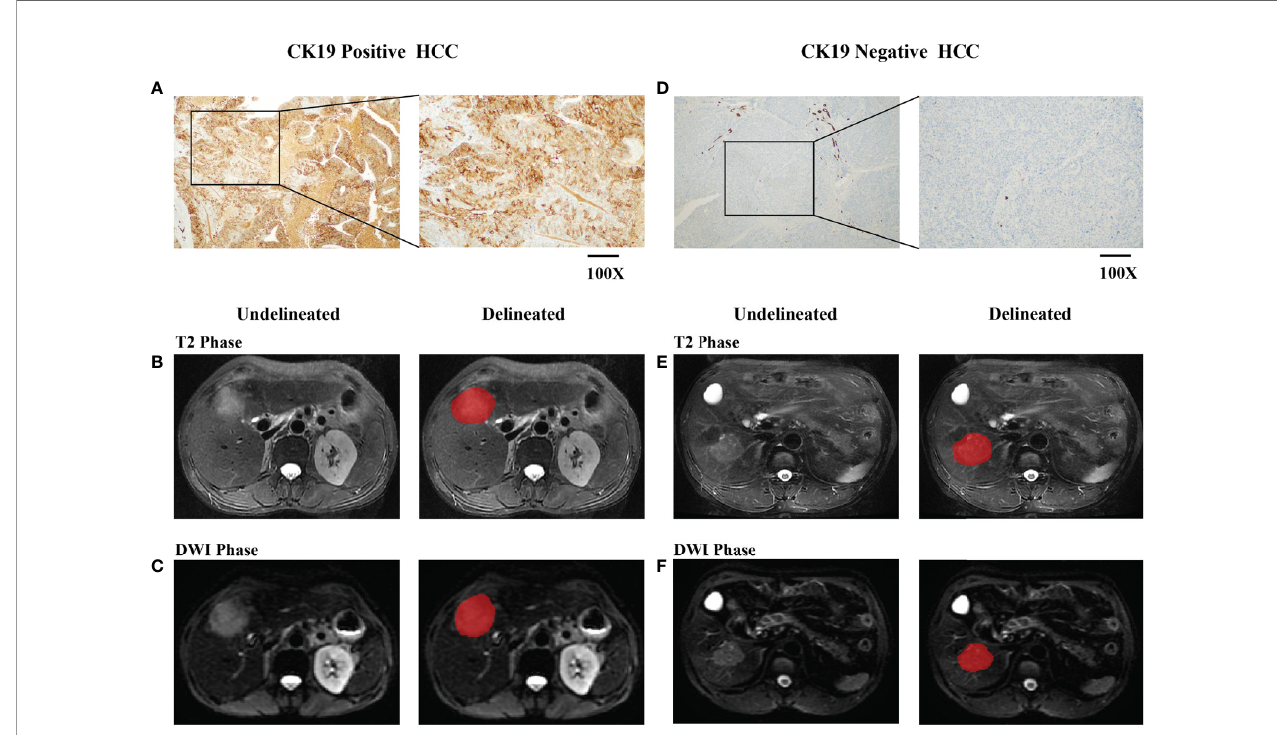
FIGURE 2 | Delineation of the region of interest (ROI). Immunohistochemistry (IHC) staining-based grouping of cytokeratin (CK)19 expression [ (A) , CK19 positive; (D) , CK19 negative]. Undelineated and delineated image of contrast-enhanced T2-weighted imaging [ (B) , CK19 positive; (E) , CK19 negative]. Undelineated and delineated image of contrast-enhanced diffusion-weighted imaging [ (C) , CK19 positive; (F) , CK19